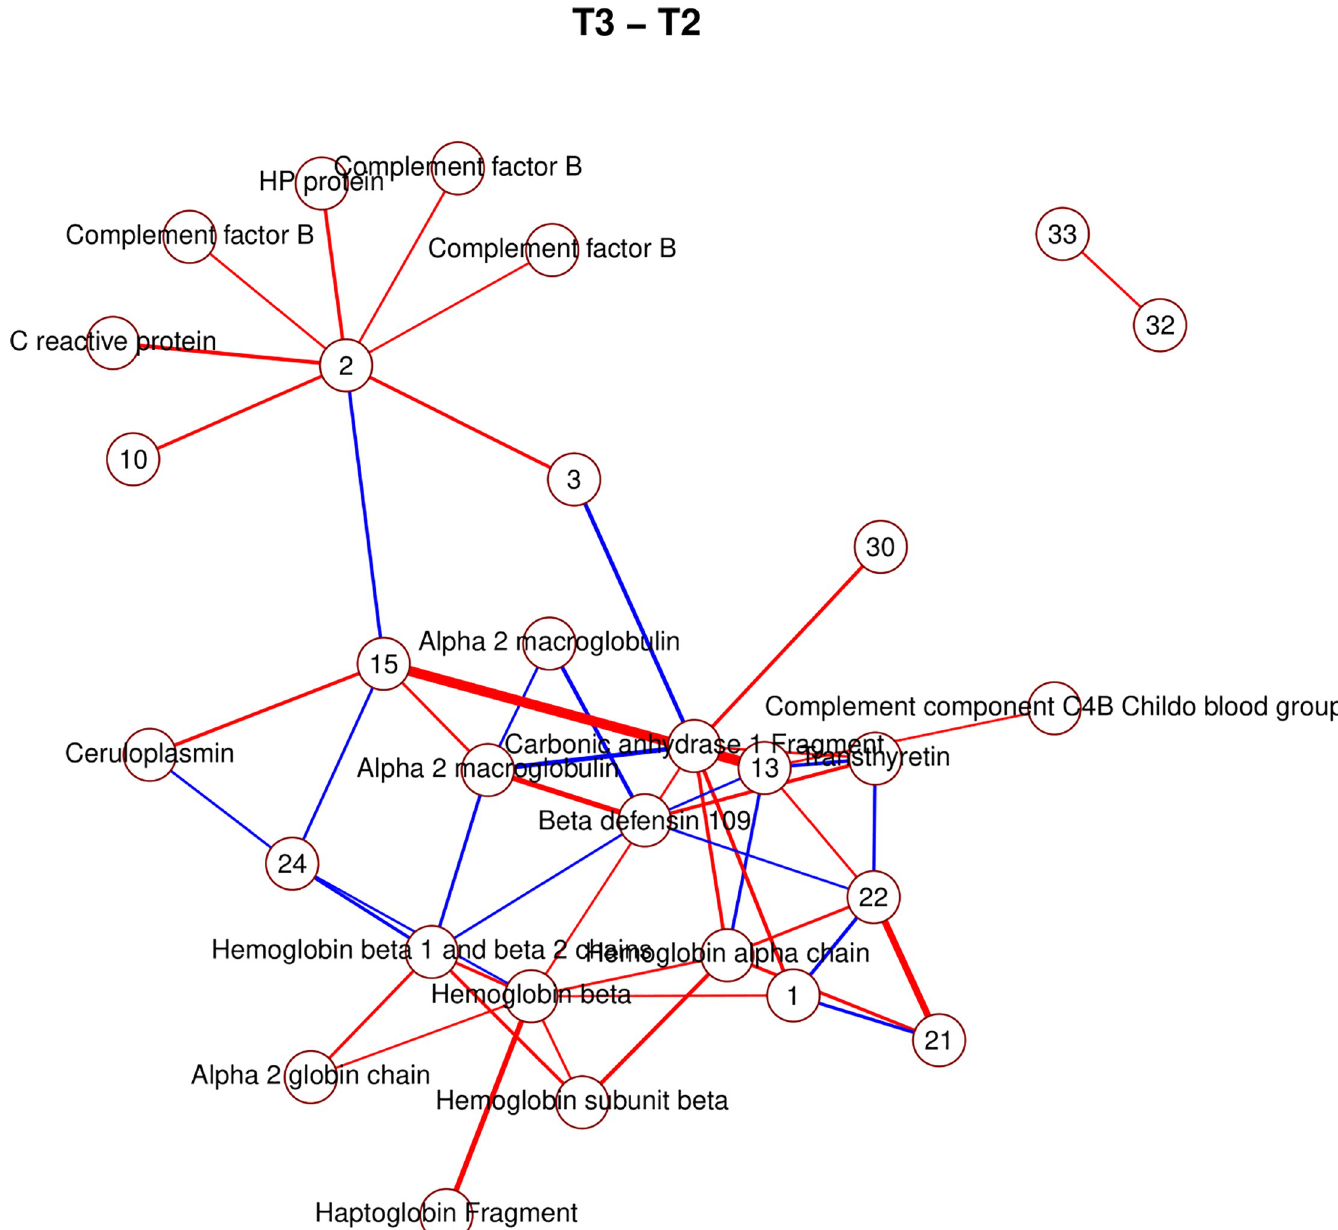
Fig 7. Non-zero partial correlations between differences in spot intensities from t 2 to t 3 displayed as a conditional independence network. Line width is proportional to the strength of the partial correlation and color represents positive (red) or negative (blue) partial correlation.